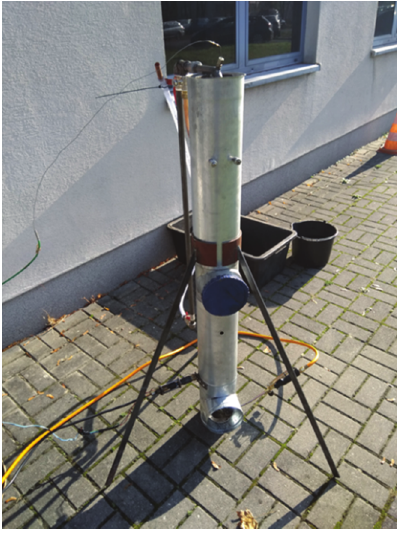
Fig. 7. A reactor for the production of synthesis gas